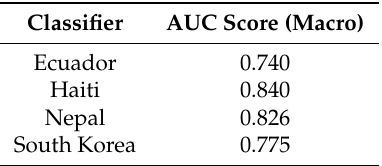
Figure 12. South Korea—ROC curves for each class of test dataset. Samples for classes 1 and 3 are identified in a similar trend, whereas class 3 has a maximum true positive rate achieved by the classifier. Several sample data of class 4 are taken as false positive, hence could not fulfill the threshold. Table 10. AUC score of